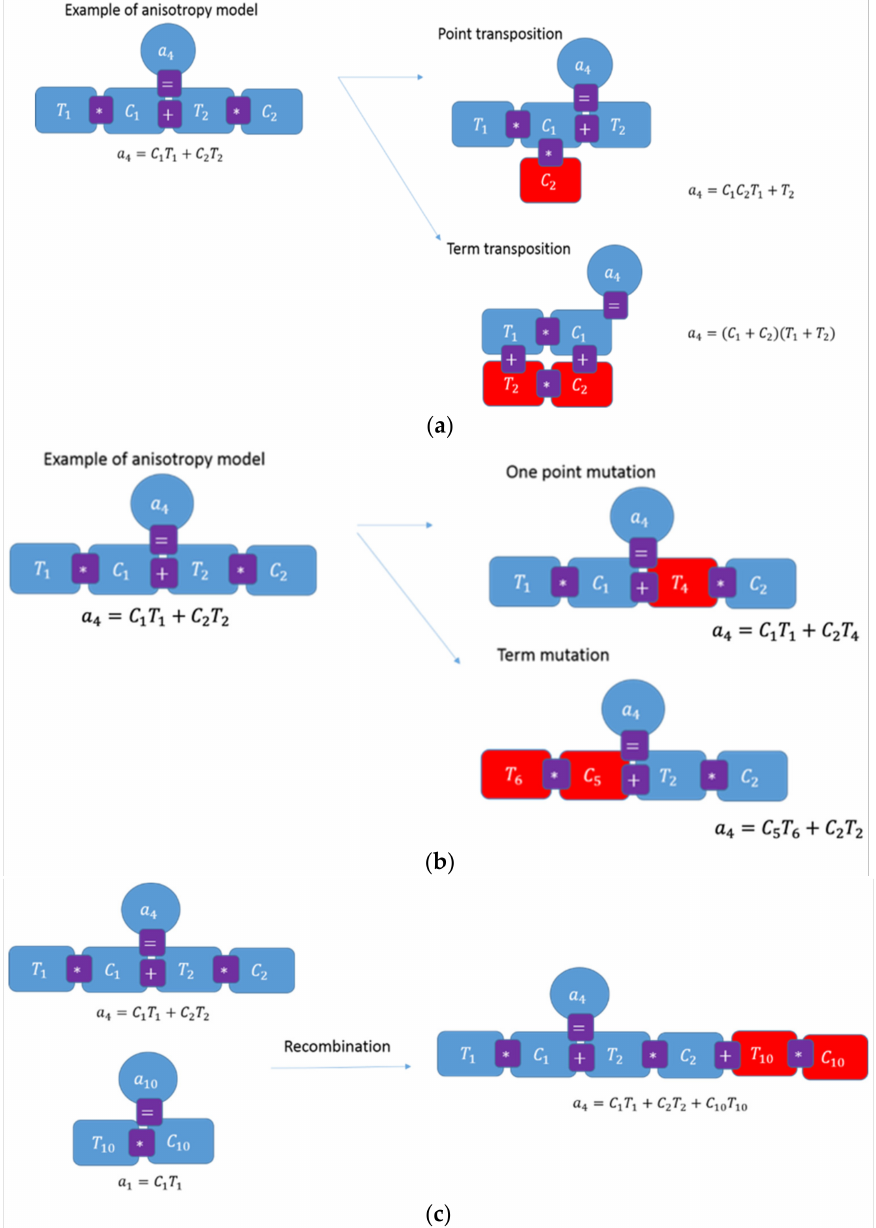
Figure 3. Examples of the genetic operations implemented in for the optimization of the turbulent anisotropy tensor ( a ) Point transposition and term transposition; ( b ) One point mutation and term mutation; ( c )